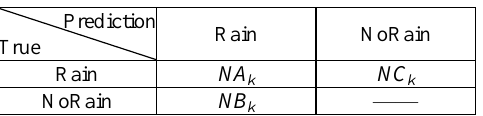
Table 2. Classification of rainfall forecast test